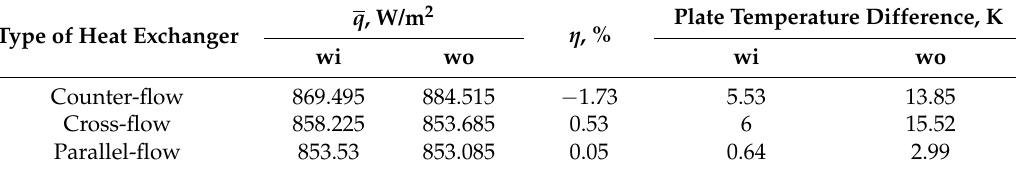
Table 2. Results of calculation for different heat exchangers in unbalanced flow: average heat flux q ; contribution of longitudinal heat conduction η ; plate temperature